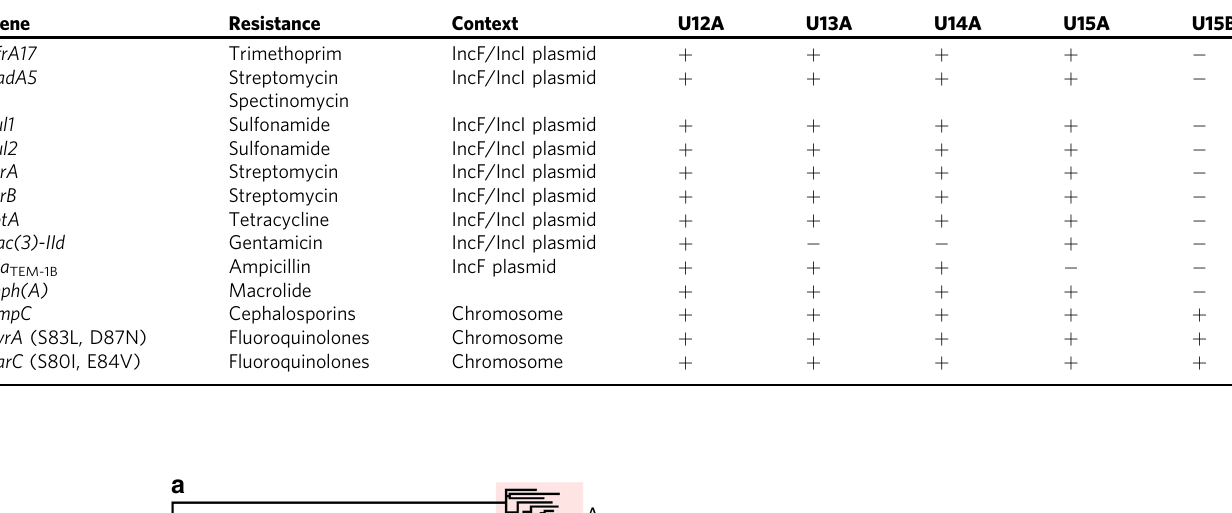
Table 1 Antibiotic resistance pro fi les of P1A isolates